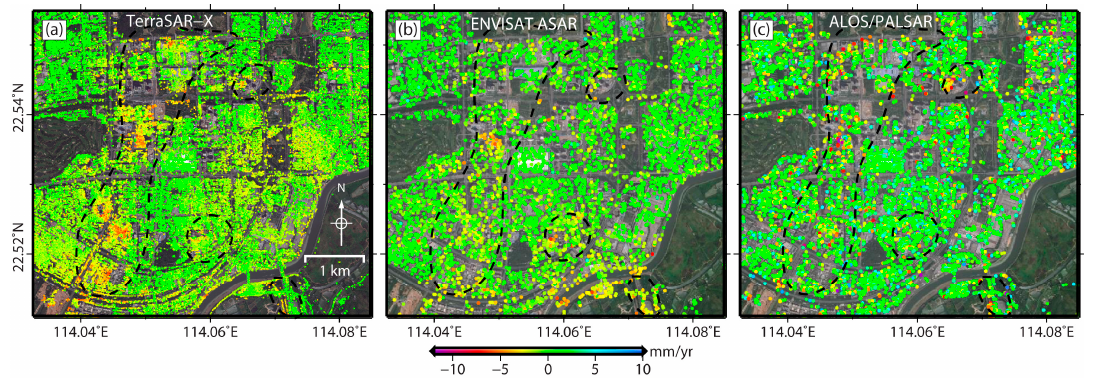
Figure 10. Comparison of mean deformation rates of Luohu district for: X band ( a ); C band ( b ); and L band ( c ).